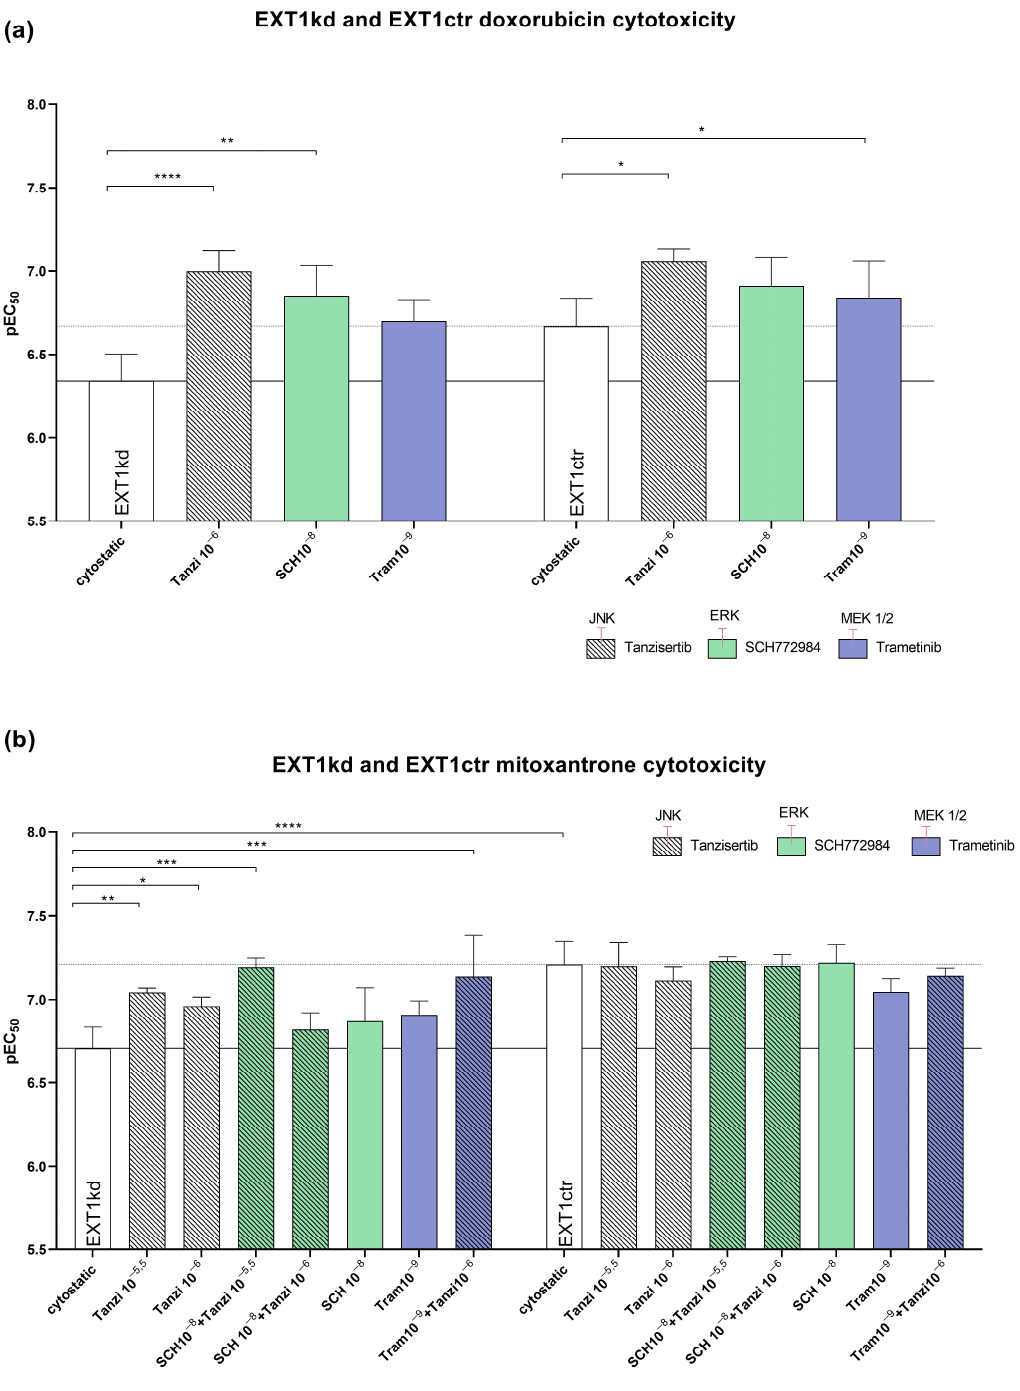
Figure 5. Effect of blocking JNK, ERK, and MEK by using tanzisertib, SCH772984, and trametinib at non-toxic concentrations to sensitize MV3 EXT1kd and MV3 EXT1ctr cells to cytotoxicity by doxorubicin ( a ) and mitoxantrone ( b ). Cytotoxicity (EC 50 values) was given by pEC 50 of at least n = 3 for ( a , b ). For statistics, an ANOVA was performed (* = p < 0.05, ** = p < 0.01, *** = p < 0.001, **** = p < 0.0001). Tanzi = tanzisertib; SCH = SCH772984; Tram = trametinib. Exponents indicate the concentration used of inhibitor in mol.